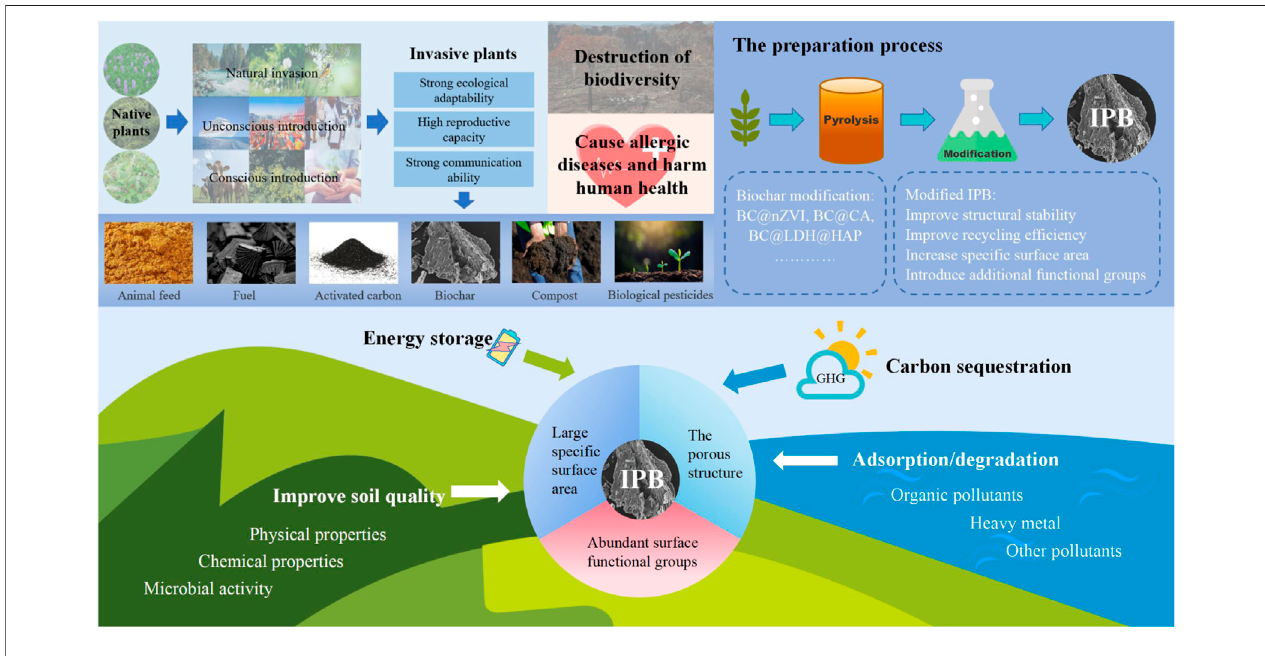
FIGURE 1 | Characteristics of invasive plants, IPB preparation and